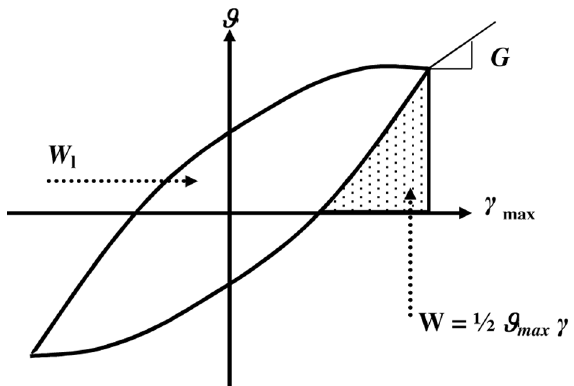
Fig. 9. Stress-strain relationships at different strain amplitude showing D and G (Zhang et al.